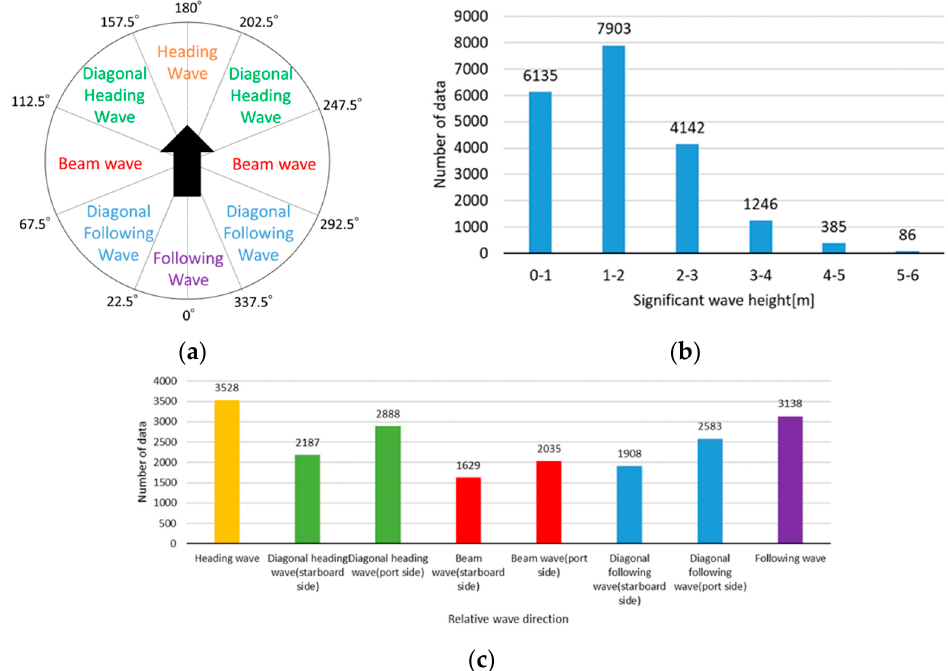
Figure 6. ( a ) Classification of the relative wave directions, ( b ) frequency distribution of the significant wave height, ( c ) frequency distribution of the relative wave direction.